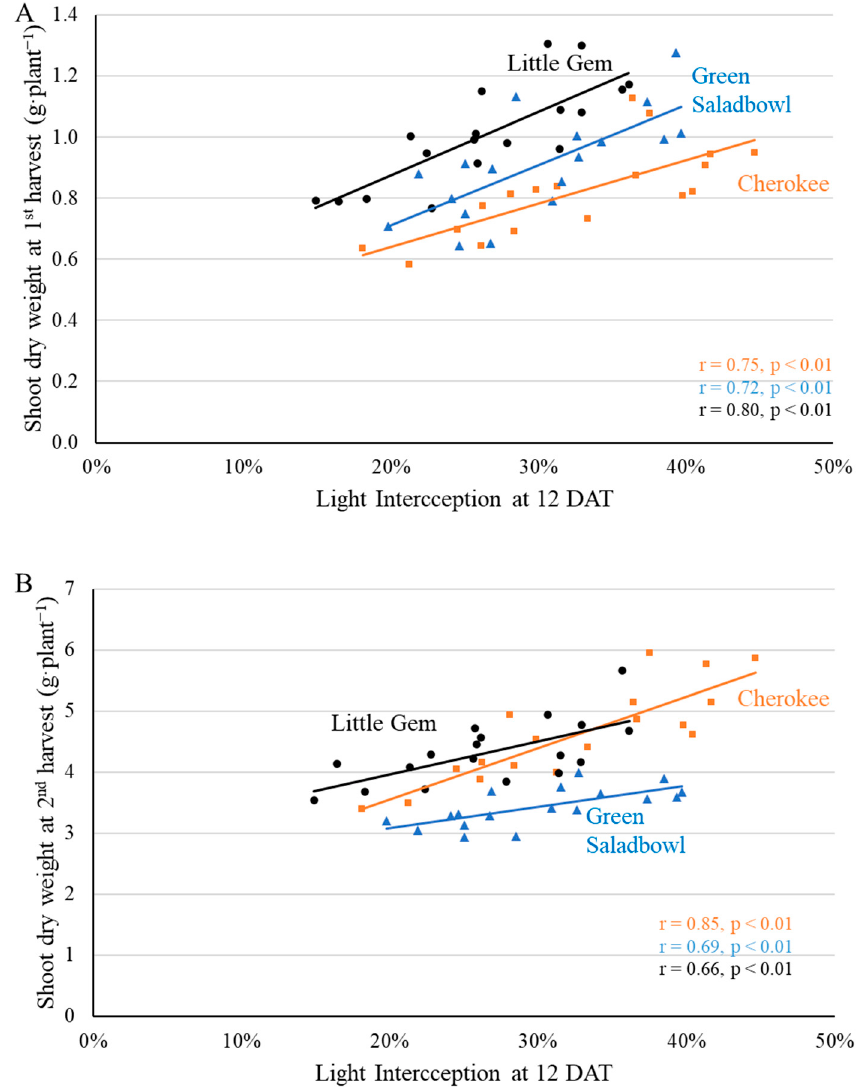
Figure 13. Canopy light interception at an early growth stage (12 DAT) strongly correlated with shoot dry weight at both harvests for ‘Cherokee’, ‘Green Saladbowl’, and ‘Little Gem’ lettuce (( A ): 1st harvest, ( B ): 2nd harvest). The r and p values for regression of each cultivar are shown with the respective color.